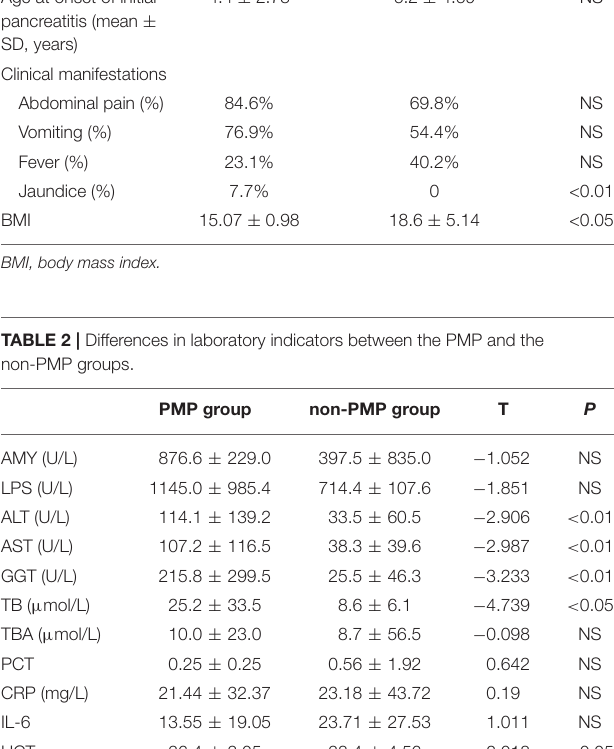
TABLE 1 | Differences in clinical profiles between the PMP and the non-PMP groups.